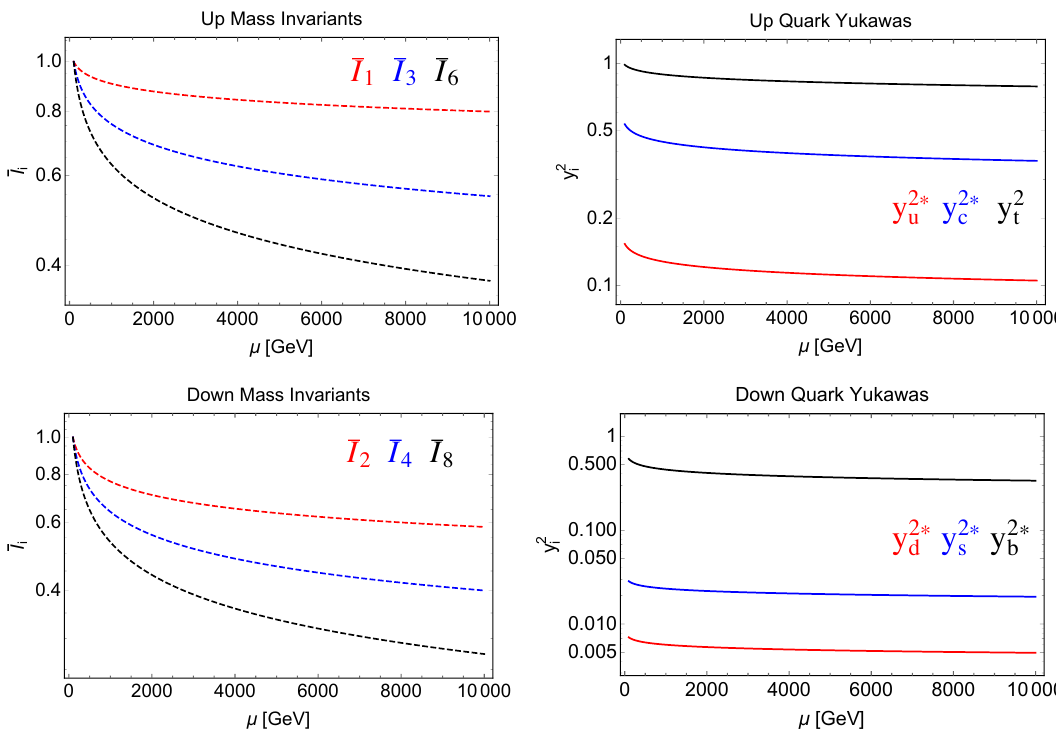
Figure 1 . Top left : running of the (normalized) unmixed invariants relevant for up-quark Yukawa extraction at one-loop order. Top right : the same for the actual up-quark Yukawa eigenvalues (squared). Note that we have rescaled the up and charm eigenvalues by 10 9 and 10 4 respectively, hence the starred ( ? ) notation. Bottom left : running of the (normalized) unmixed invariants relevant for down-quark Yukawa extraction at one-loop order. Bottom right : the same for the actual down- quark Yukawa eigenvalues (squared). We have again rescaled the eigenvalues for the purpose of plotting, multiplying the bottom, strange, and down eigenvalues by 10 3 , 10 5 and 10 7 respectively.